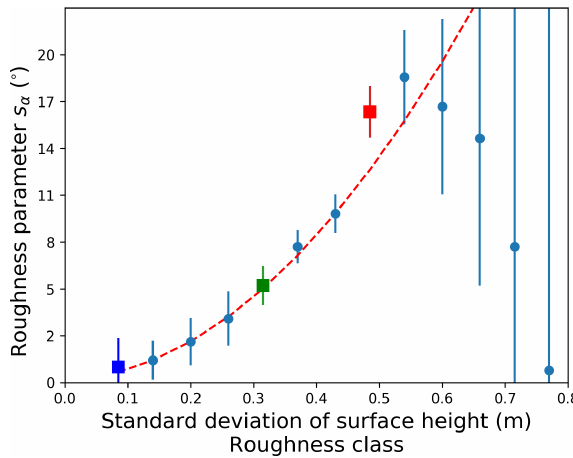
Figure 5. Surface roughness parameter s α describing the probabil- ity distribution of surface slopes. Error bars are inversely propor- tional to the number of data points in each roughness class. The “smooth”, “medium rough”, and “rough” classes are marked in the colours blue, green, and red, respectively. The red dashed line marks the fitted curve.